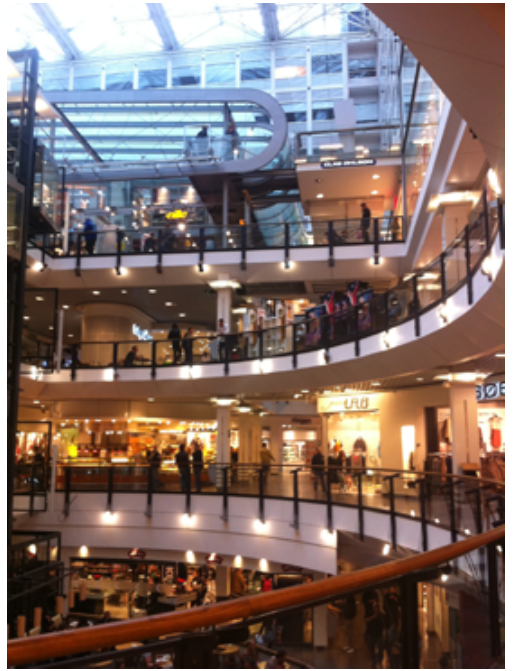
Figure 9. Shopping mall (Study